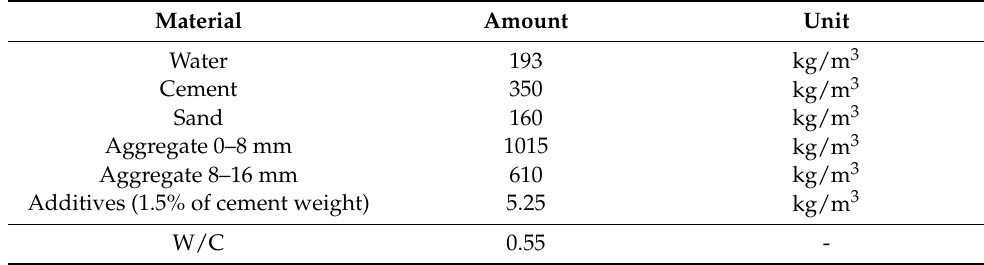
Table 1. Concrete mix used for all